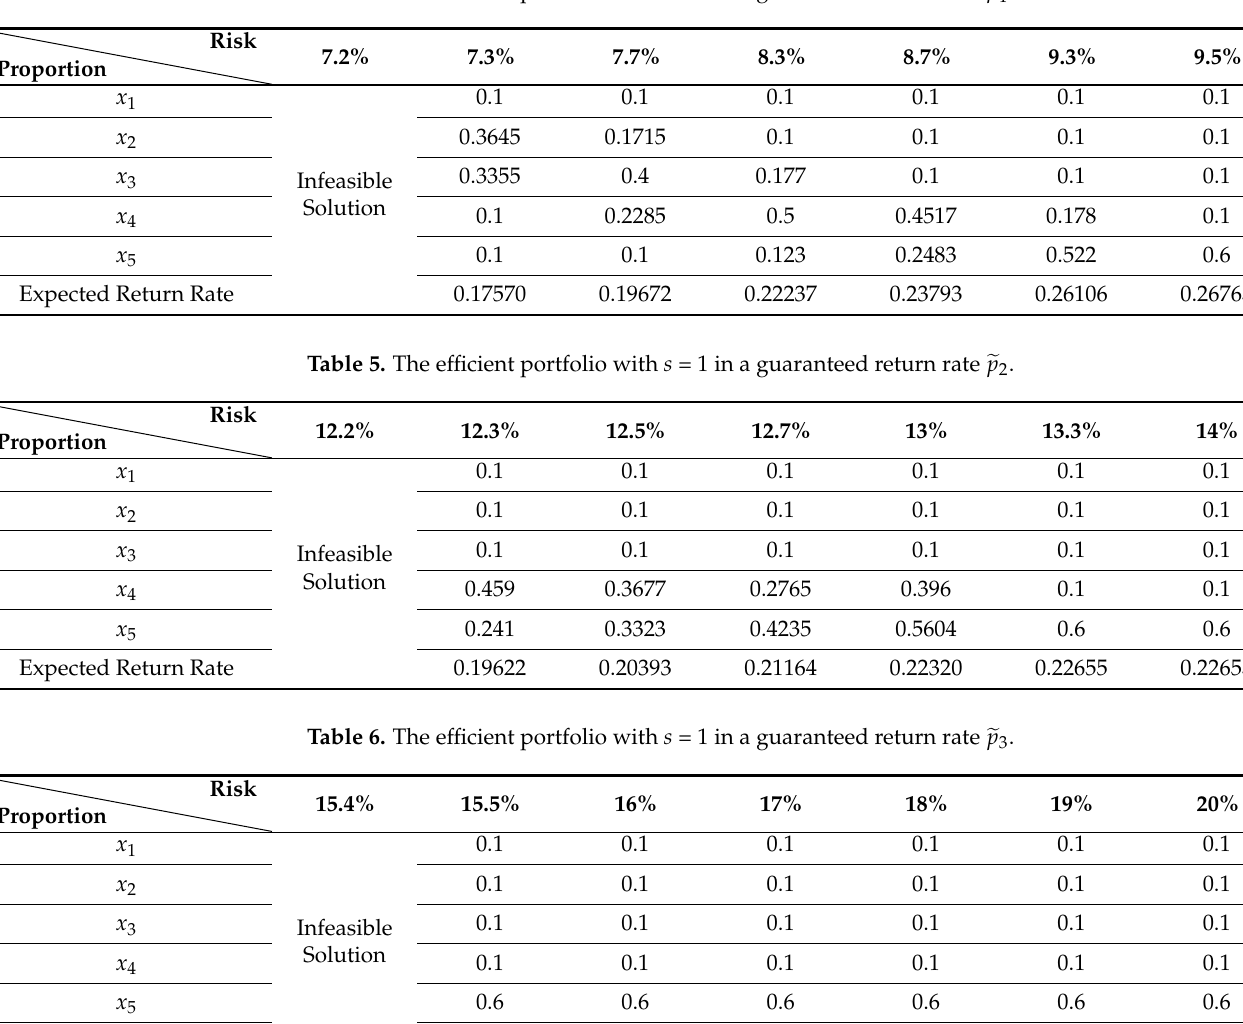
Table 4. The efficient portfolio with s = 1 in a guaranteed return rate (cid:101) p 1 .